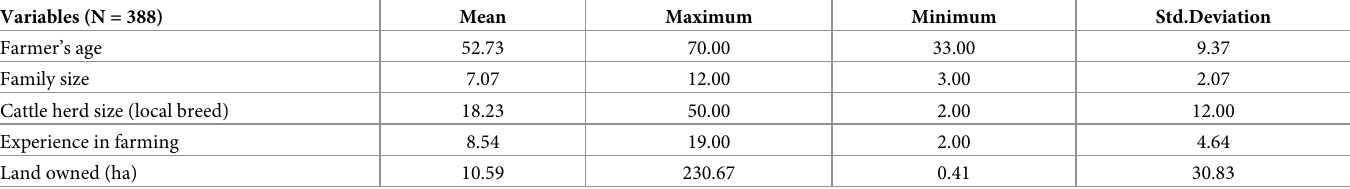
Table 3. Socioeconomic characteristics of smallholder beef cattle farmers based on mean scores of continuous